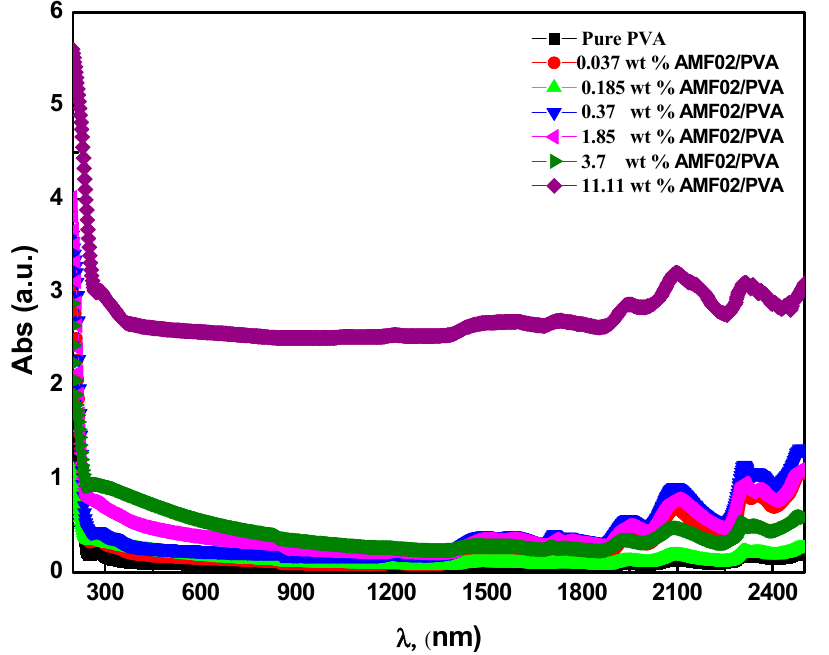
Figure 4. Absorption spectra of pure PVA and AMF02/PVA novel PCCEFs.